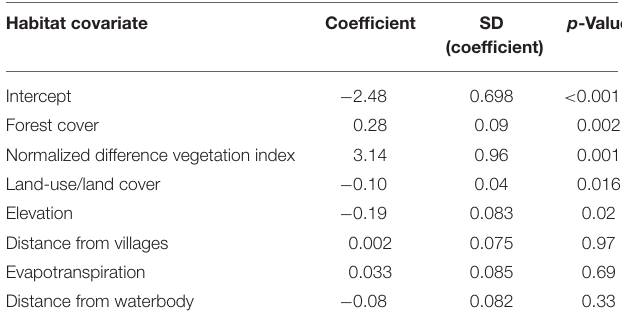
TABLE 2 | GLM coefficient with associated standard error values and p -values depicting habitat associations of honey badger with different environmental covariates.